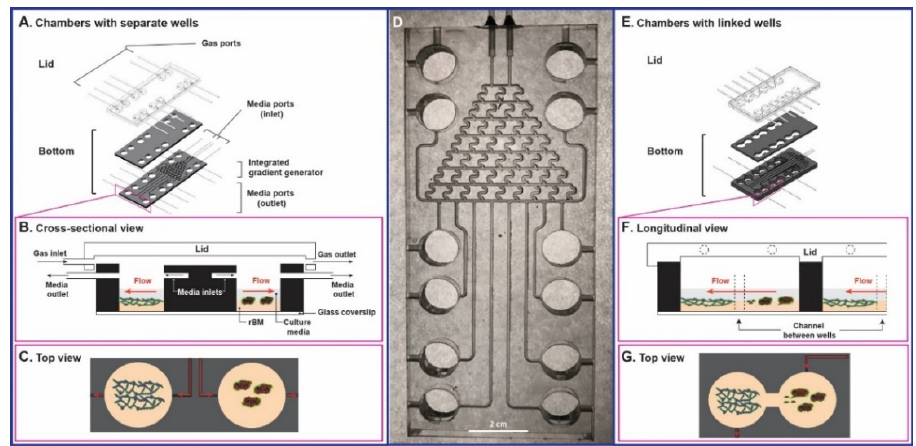
Figure 5. Schematics of TAME chambers with separate wells ( A – D ) or linked wells ( E – G ). Exploded ( A , E ), cross-sectional ( B ), longitudinal ( F ), and top ( C , G ) views of chambers with separate ( A – C ) or linked ( E – G ) wells. ( D ) Photograph of prototype of chamber with separate wells and an integrated gradient generator.